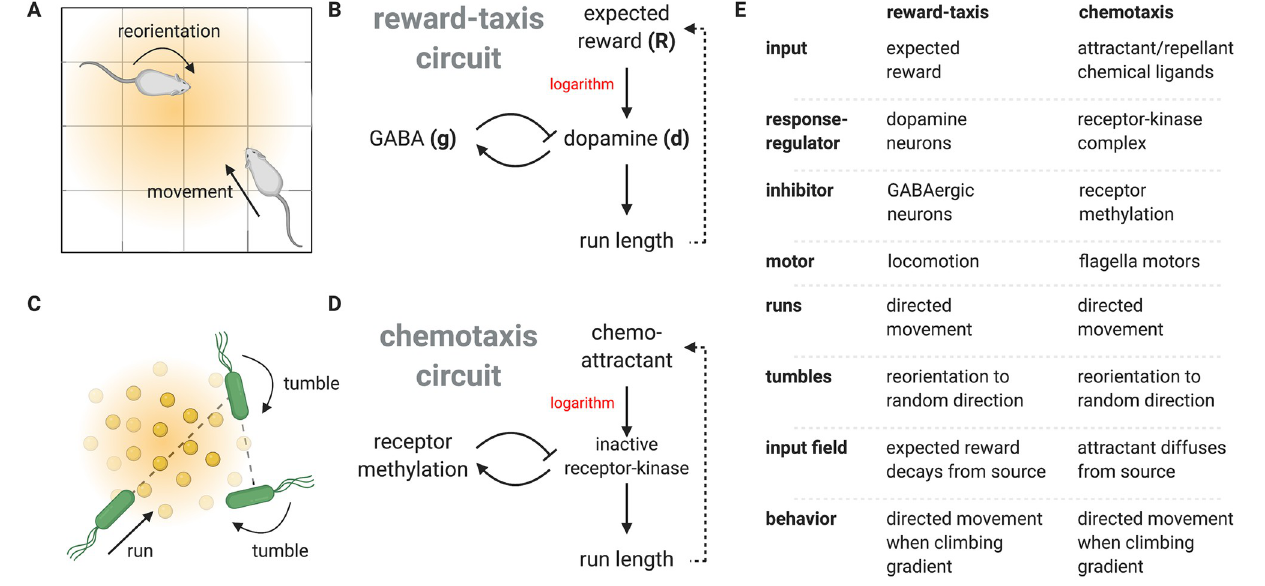
Fig 4. Dopamine regulation of behavior in the model is analogous to bacterial chemotaxis. (A) The behavior of an animal in an open field is modelled as a series of directed movements (runs). The direction of each run is chosen at random (or, more generally, stops between runs decorrelate motion direction), and the duration of each run increases with dopamine level. (B) Dopamine is controlled by an FCD circuit activated by expected reward. (CD) The reward- dopamine-behavior circuit is analogous to the chemotaxis circuit that underlies bacterial navigation towards chemo-attractants. Bacterial motion is composed of a series of runs. The direction of each run is randomized by tumbling events, and run duration increases with the inactivation of a receptor-kinase complex, which is controlled by an FCD circuit activated by chemoattractant concentration. (E) Table detailing the mapping between the dopamine system and the chemotaxis system. Figures were created with